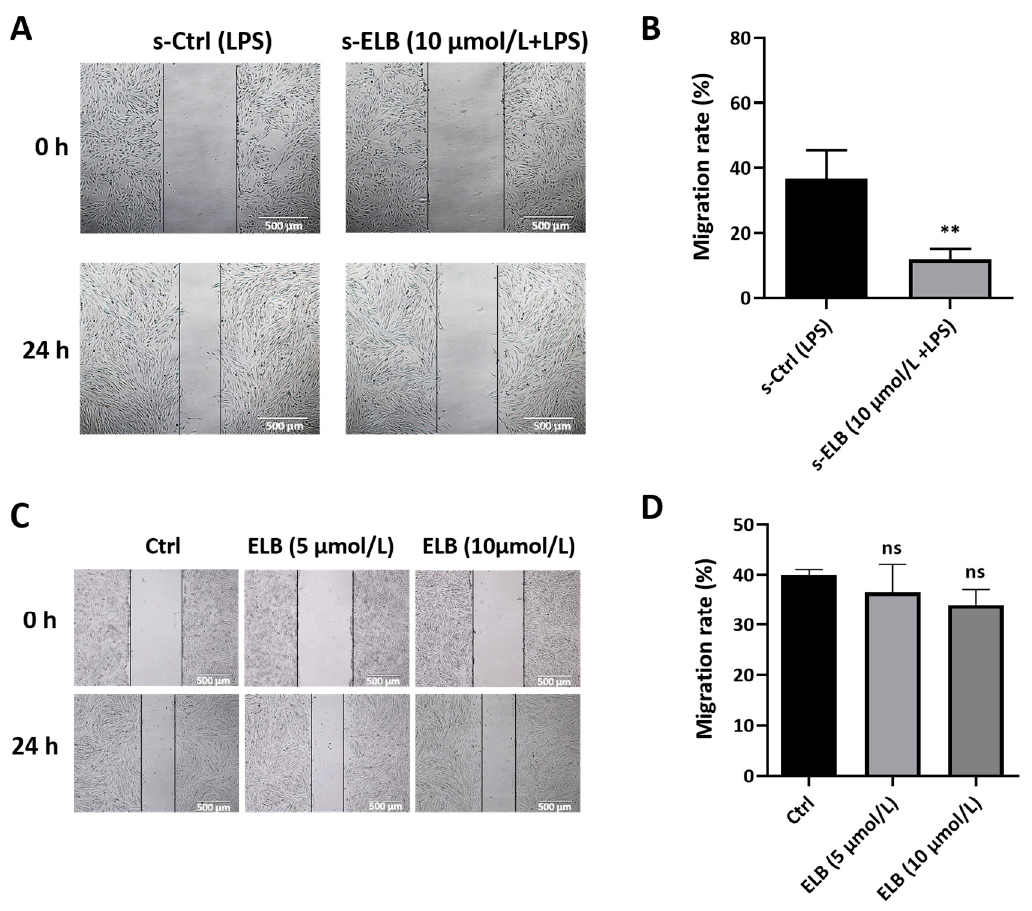
Figure 7. Eltrombopag regulated macrophage-mediated lymphangiogenesis. ( A , B ) SVEC4-10 cell migration impacted by supernatants of eltrombopag-treated macrophage, representative images (left) and quantitative analyses (right). ( C , D ) SVEC4-10 cell migration impacted by eltrombopag directly, representative images (left) and quantitative analyses (right). Scale bar: 500 μ m. Mean ± SD. n = 3. ** p < 0.01 ( t -test), ns means no significant difference.